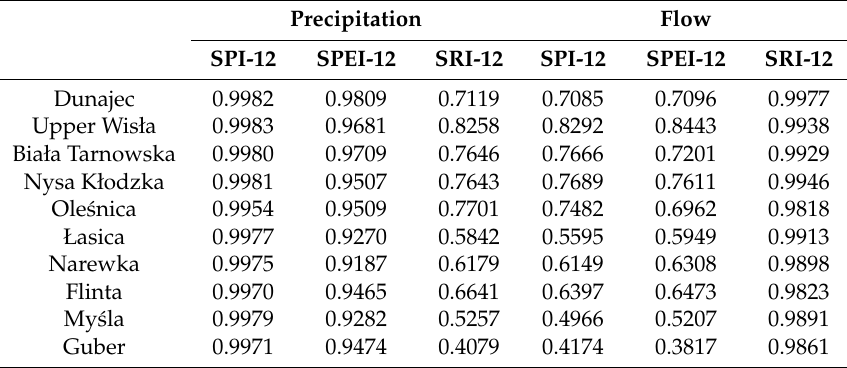
Table 7. Person correlation coefficients between three drought indices (SPI-12, SPEI-12 and SRI-12) and observed annual sums of precipitation and mean annual daily flow in the 1971–2000 period for ten catchments